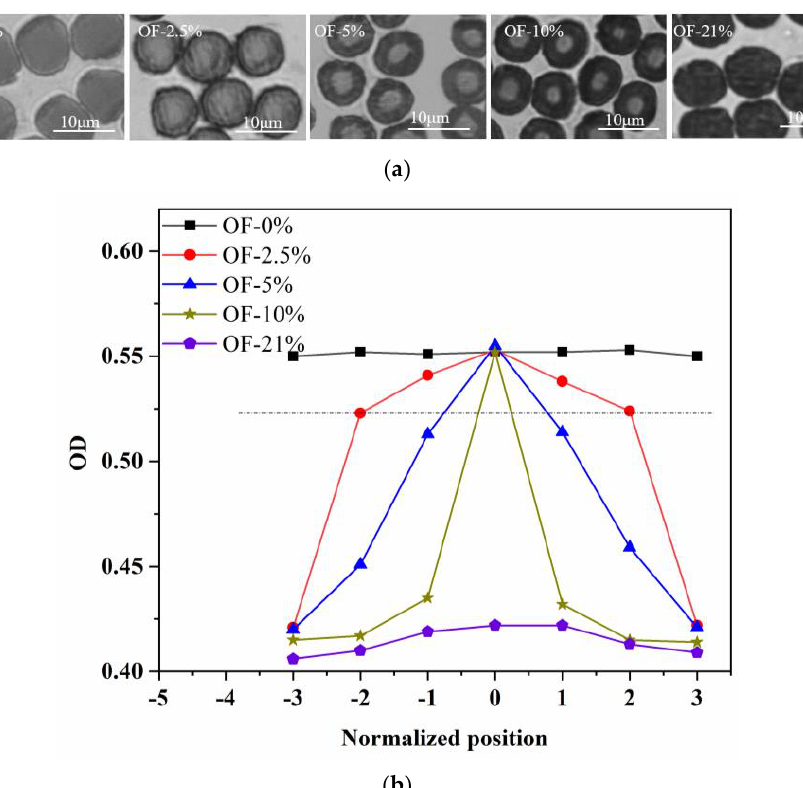
Figure 7. The translucency of the cross-section of the fine denier PAN pre-oxidized fiber by optical microscope of ( a ) cross-sectional transmittance images (Note, the diameter of each filament for pre-oxidized fiber was about 7 µ m) and ( b ) optical